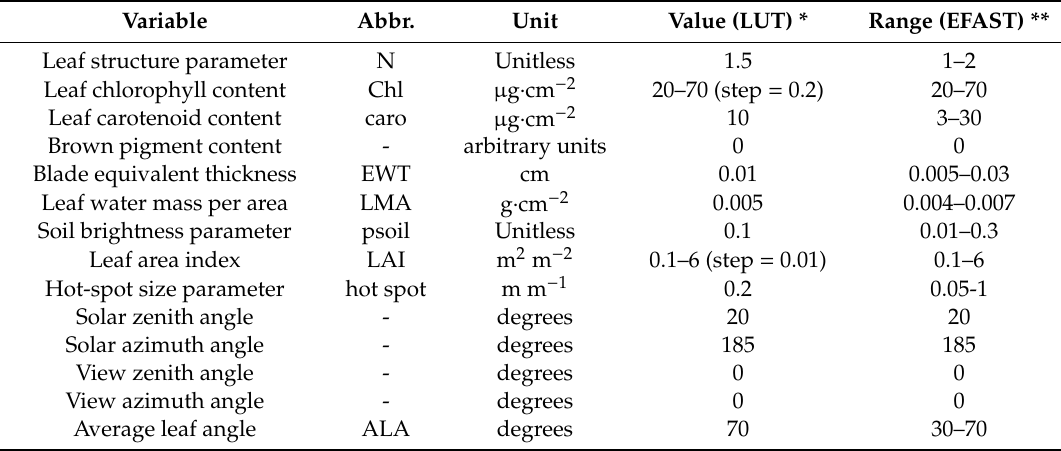
Table 6. Ranges of input variables for the PROSAIL